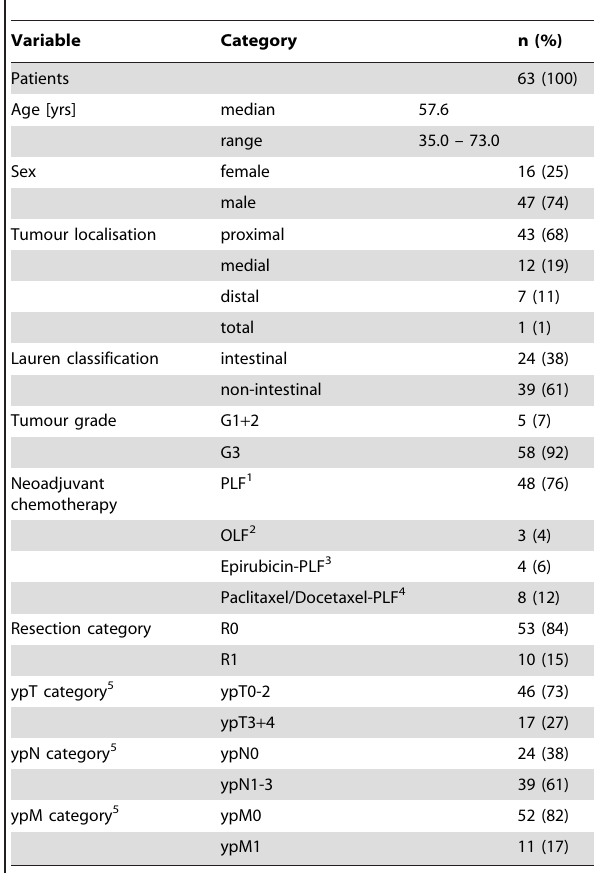
Table 1. Patient characteristics and